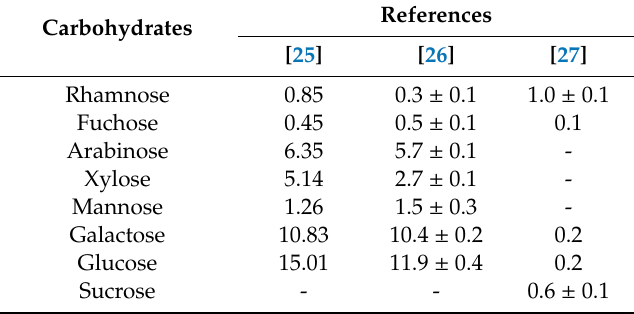
Table 3. Composition of total fibre in okara (low molecular weight carbohydrates g / 100 g dry matter). Carbohydrates